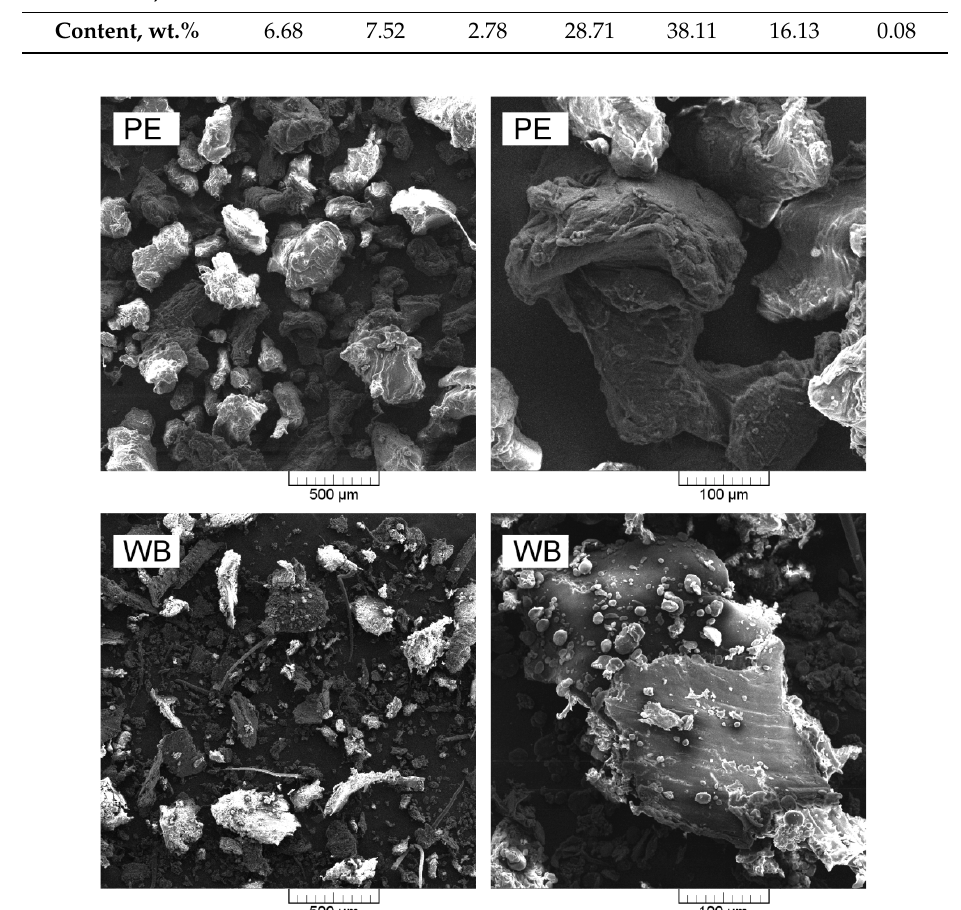
Figure 2. Scanning electron microscope (SEM) images of polyethylene powder and wheat bran.